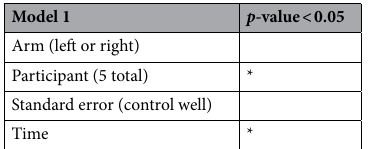
Table 1. Model included in the ANOVA analysis. Asterisks indicate parameters having p < 0.05, resulting in rejection of the null